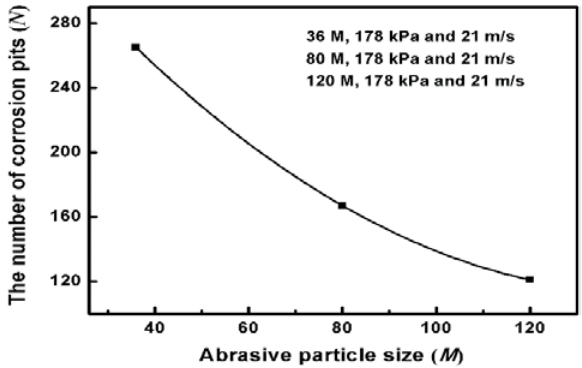
Figure 6. The number of corrosion pits per unit area at the corroded surface.